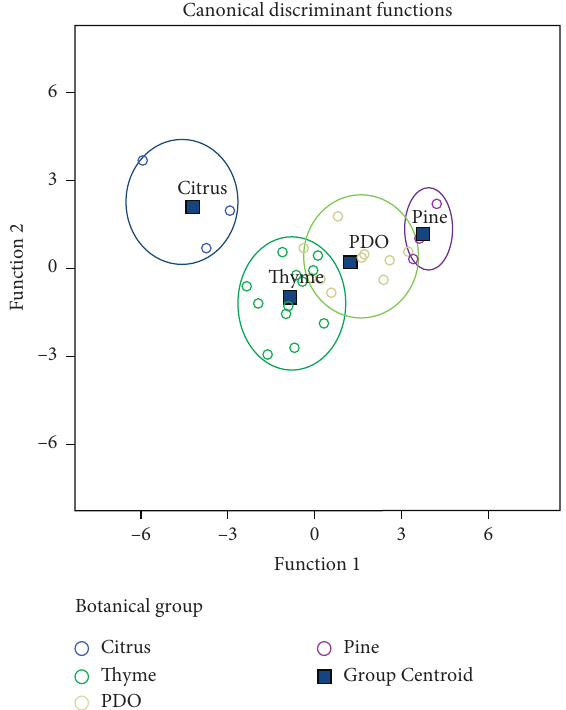
Figure 1: Canonical discriminant analysis of all honey samples